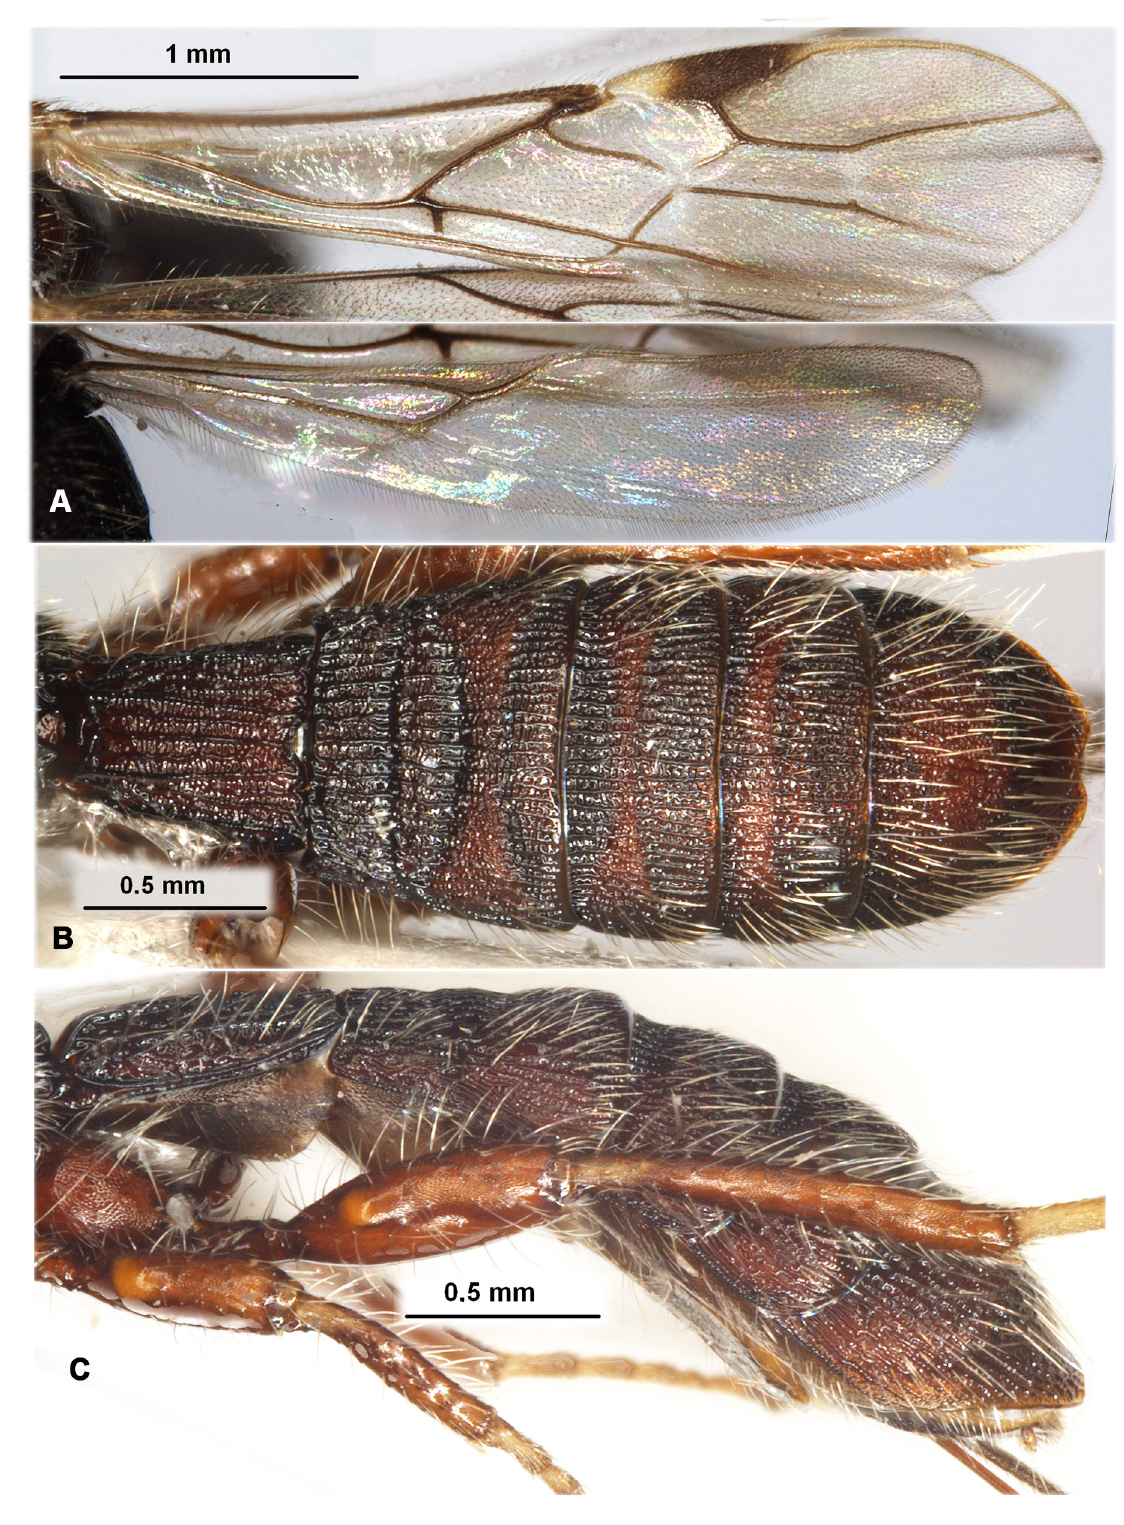
Fig. 44. Rhaconotinus ( Rh. ) albosetosus Belokobylskij sp. nov., holotype, ♀ (RMNH). A . Wings. B . Metasoma, dorsal view. C . Metasoma, lateral